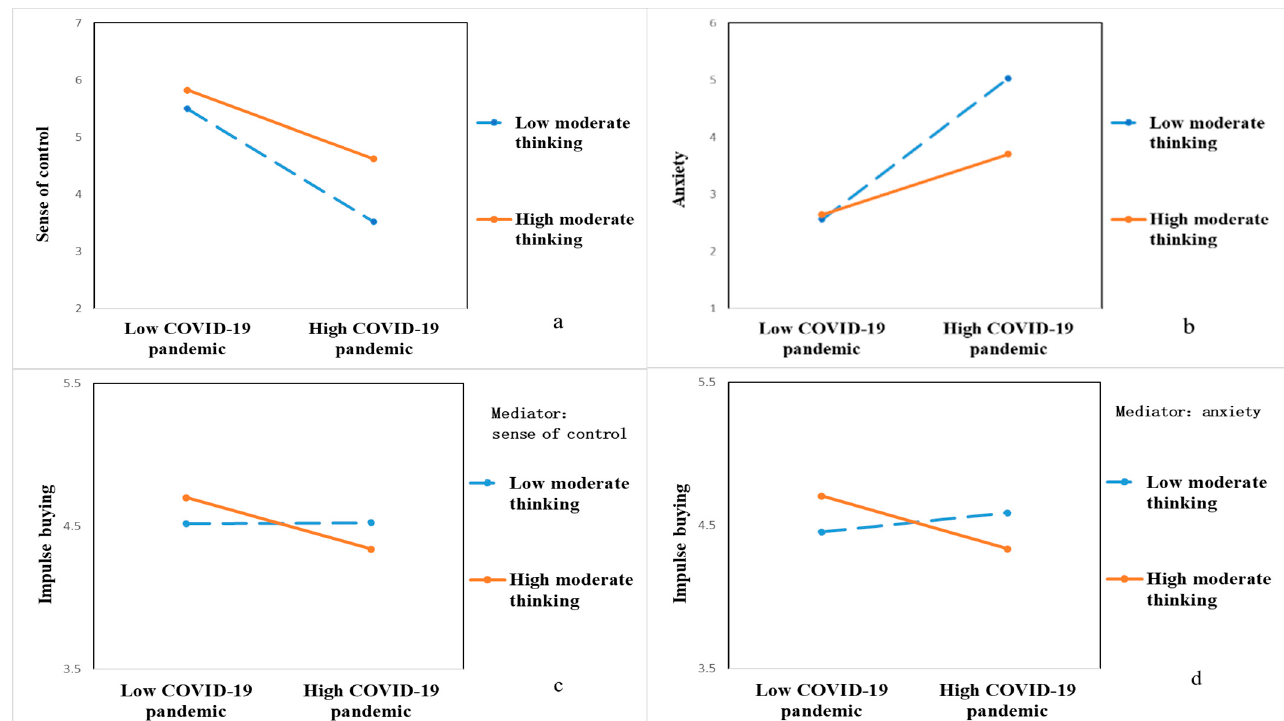
Figure 5. Moderating effects. ( a ) The moderating role of moderate thinking between COVID-19 and sense of control. ( b ) The moderating role of moderate thinking between COVID-19 and anxiety. ( c ) The moderated mediation of sense of control. ( d ) The moderated mediation of anxiety.